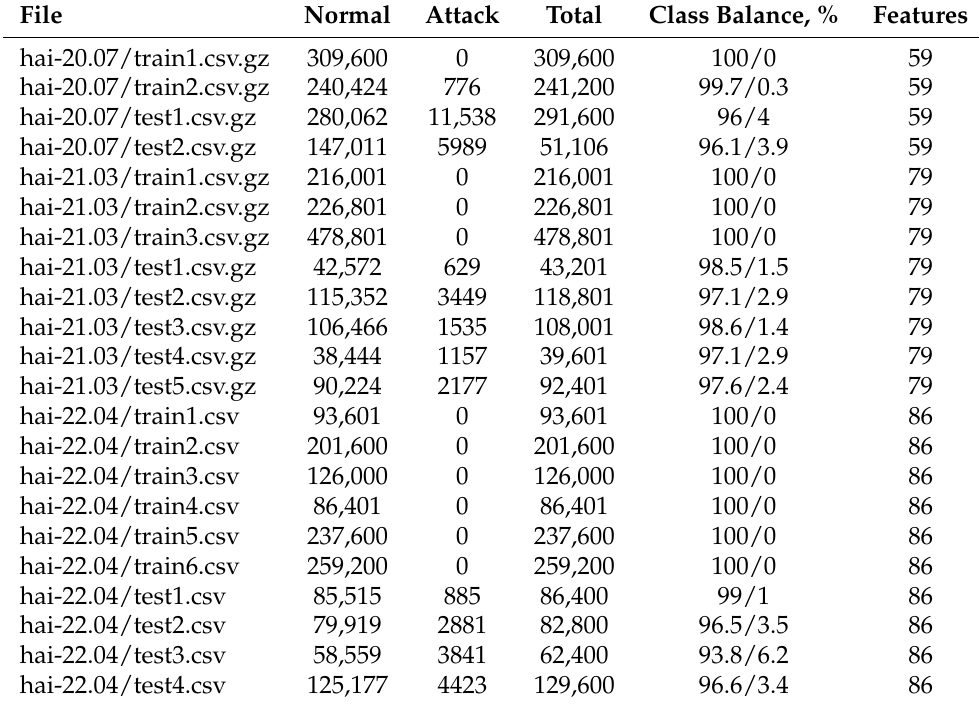
Table 9. Statistical data on the HAI dataset class balance by